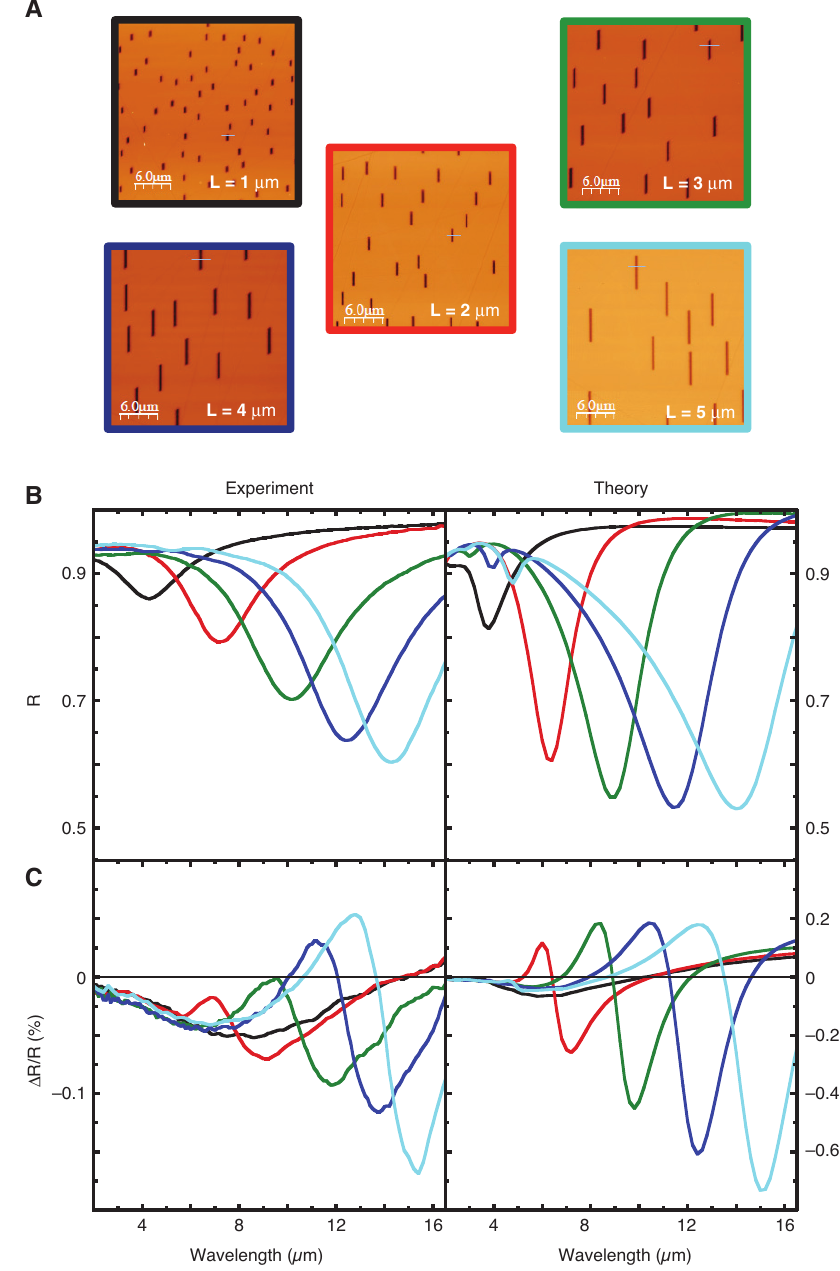
Figure 3: Dependence of the reflectivity and its magnetic field modulation on the slit length. (A) Representative atomic force microscopy images of the slit arrays fabricated by FIB in a single 1 × 1 cm 2 Ni different slit lengths: black line 1 micron, red line 2 microns, green line 3 microns, blue line 4 microns, cyan line 5 microns. All the arrays have the same areal slit concentration (2.1% of the total area). (B) Experimental (left) and theoretical (right) reflectivity of the arrays. Light incidence is normal to the slits and with polarization perpendicular to the slit long axis. (C) Magnetic modulation of the reflectivity for the different arrays. I represents the modulation intensity of the slit MR